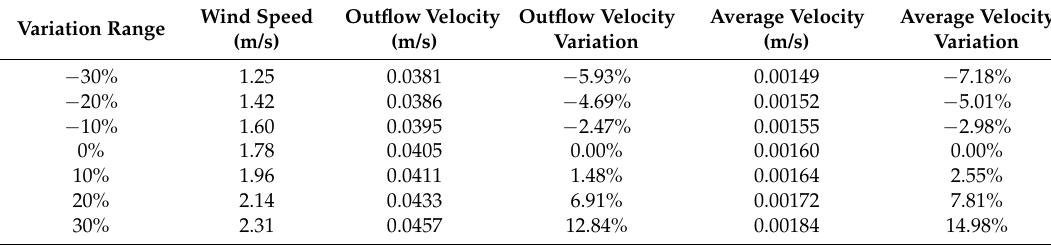
Table 1. Effect of wind speed on flow